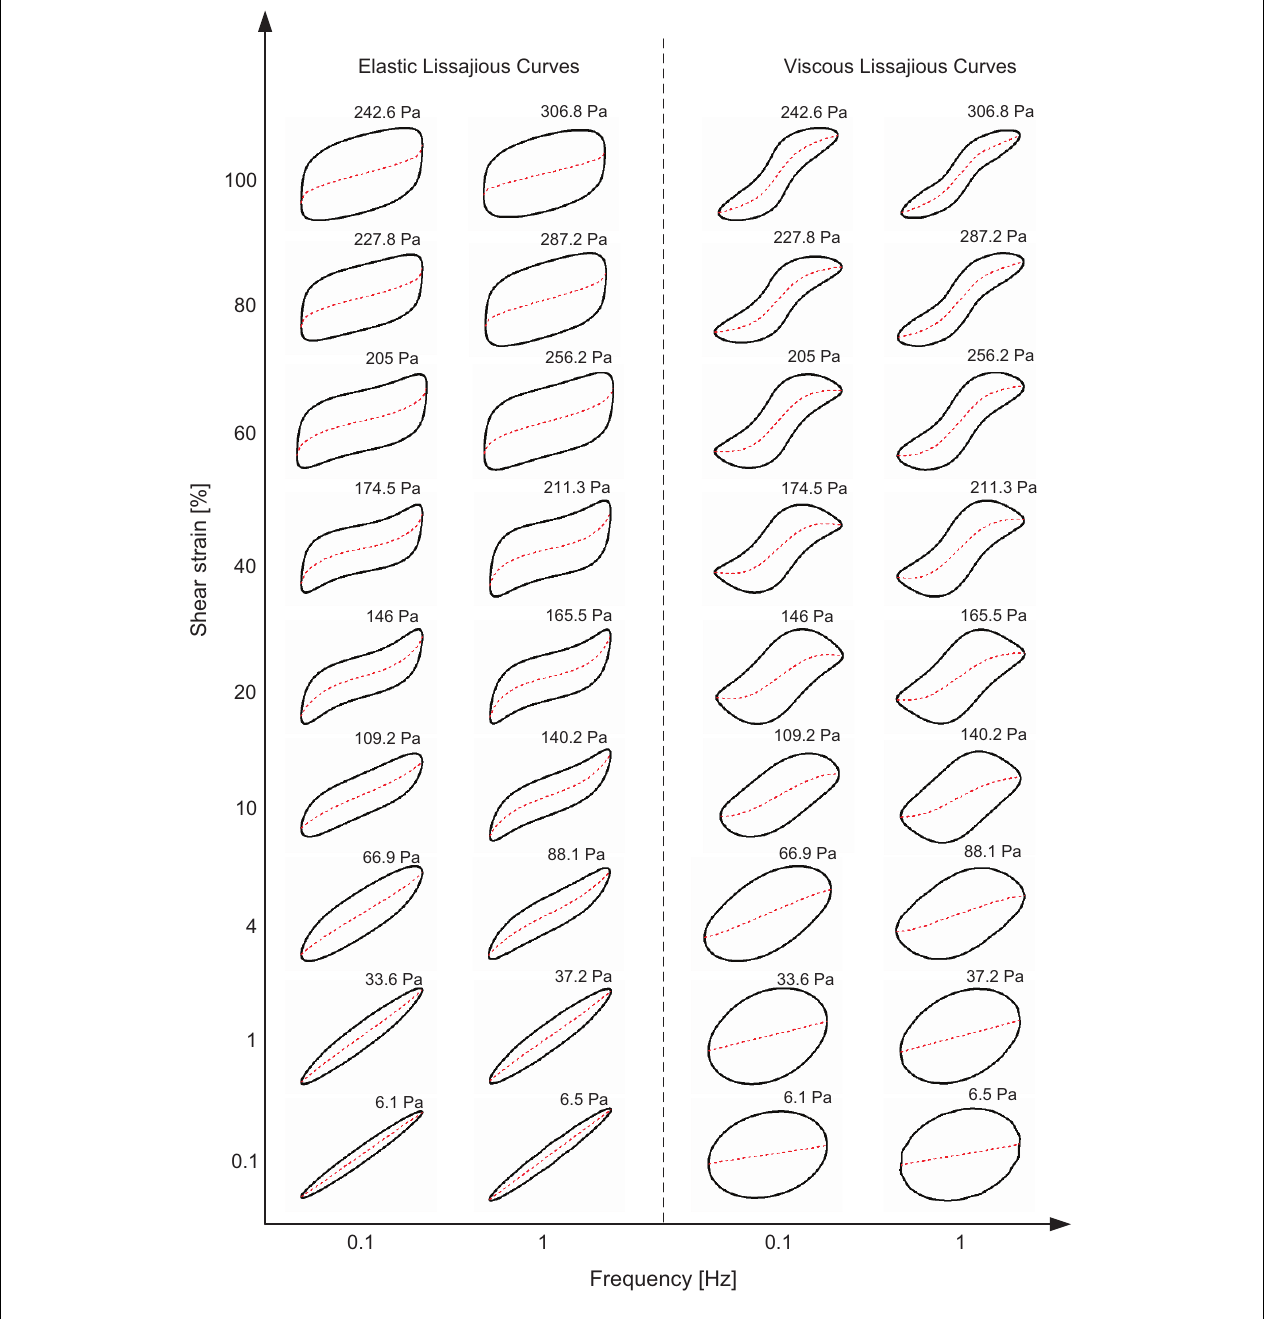
FIGURE 5 | Elastic and viscous Lissajous curves of MRG-70 generated from the strain-controlled oscillatory shear under the magnetic field of 0 kA/m. Each curve is positioned according to the imposed value of shear strain and frequency. The red dash line represents the corresponding decomposed elastic and viscous stress, respectively. The value above each curve is the maximum shear stress τ max